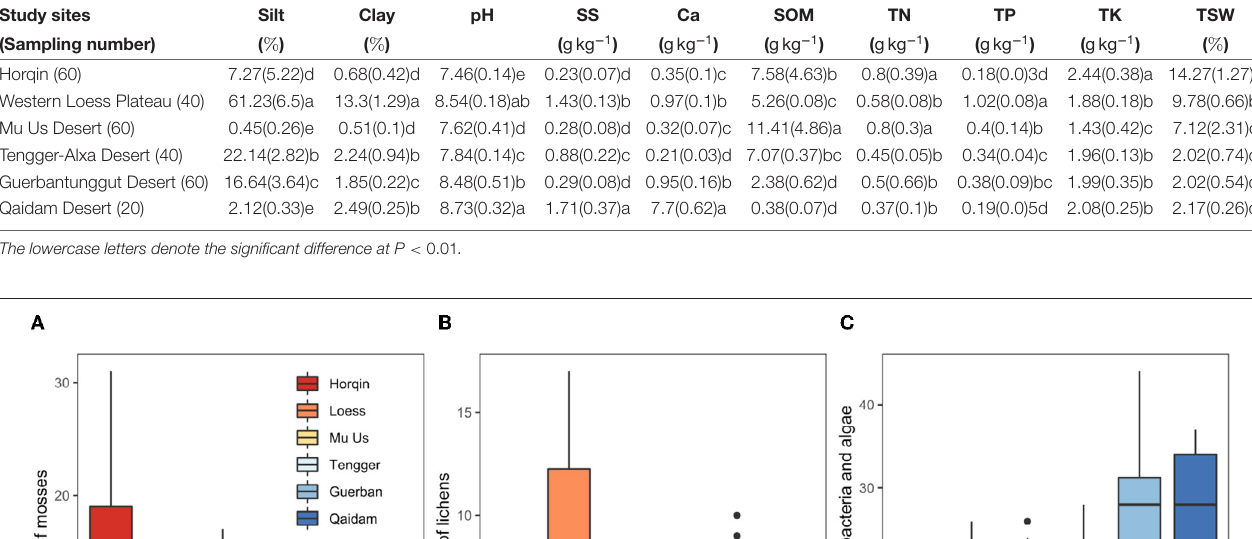
TABLE 1 | Abiotic indicators (mean (SD)) of topsoil under the biocrust layer at six sites in northern Chinese deserts. Study sites